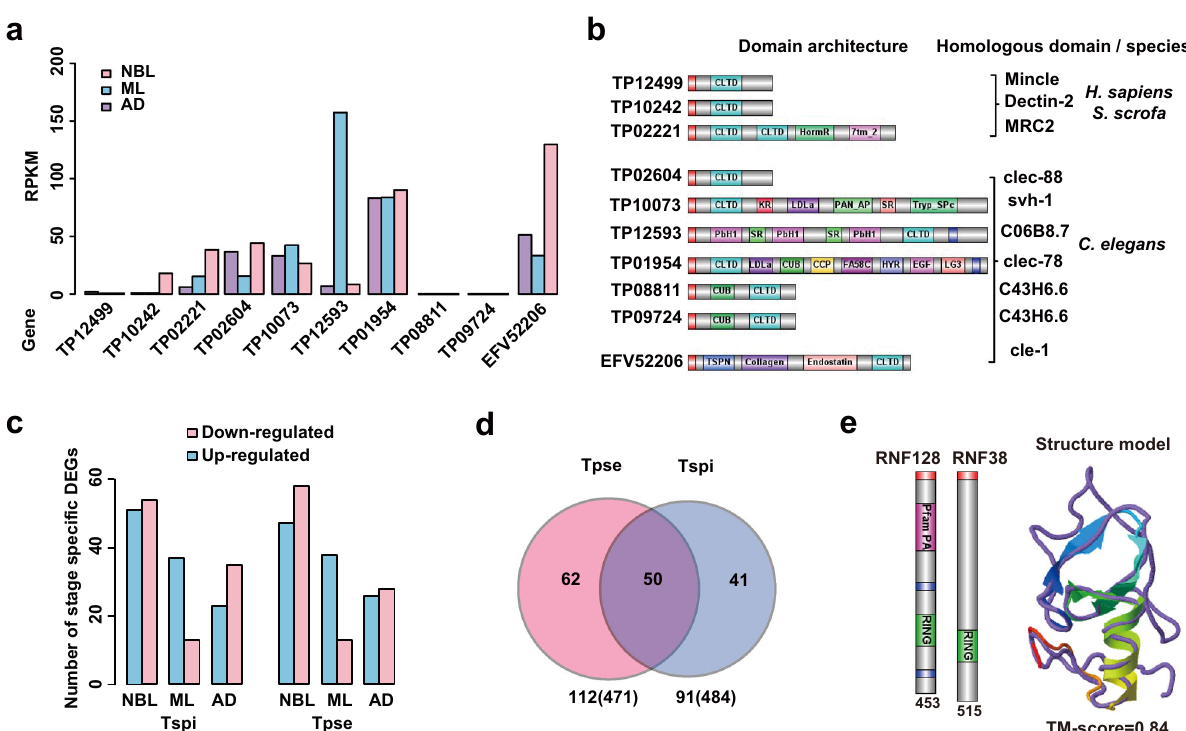
Fig. 5 Stage-speci fi c expressed E/S genes form the basis of varied parasitism between T. pseudospiralis and T. spiralis . a The histogram shows expression levels of secreted C-type lectin superfamily across three life stages. b Domain architecture (left) and homologous domain sequences (right) in mammalian host of C-type lectin superfamily. c The histogram shows numbers of stage-speci fi cally differential expressed genes (DEGs) between the two species across three life stages. d Venn diagram of homologous SCOs between total SCOs identi fi ed in the two species. e Domain architectures and structural model of TP12446 and RNF38. The subgraph numbers indicate the protein length. Query structure is shown in cartoon, while the structural analog in the PDB library is displayed using backbone trace and colored in purple (as identi fi ed by TM-align). The TM-score value scales the structural similarity of the two